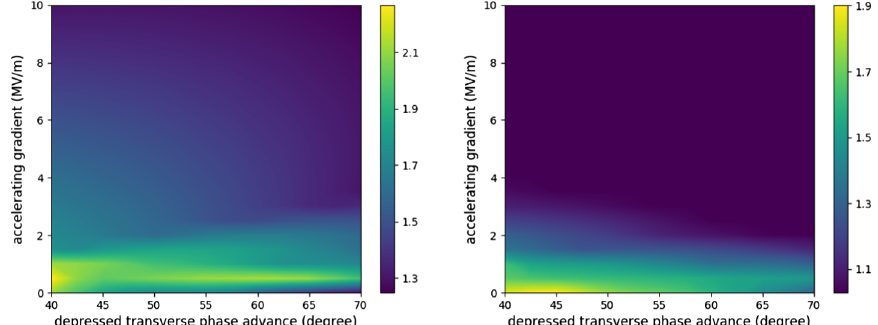
FIG. 11. The maximum normalized horizontal rms amplitude (left) and longitudinal rms amplitude (right) within 100 lattice periods as a function of accelerating gradient and depressed transverse phase advance in the quadrupole-rf